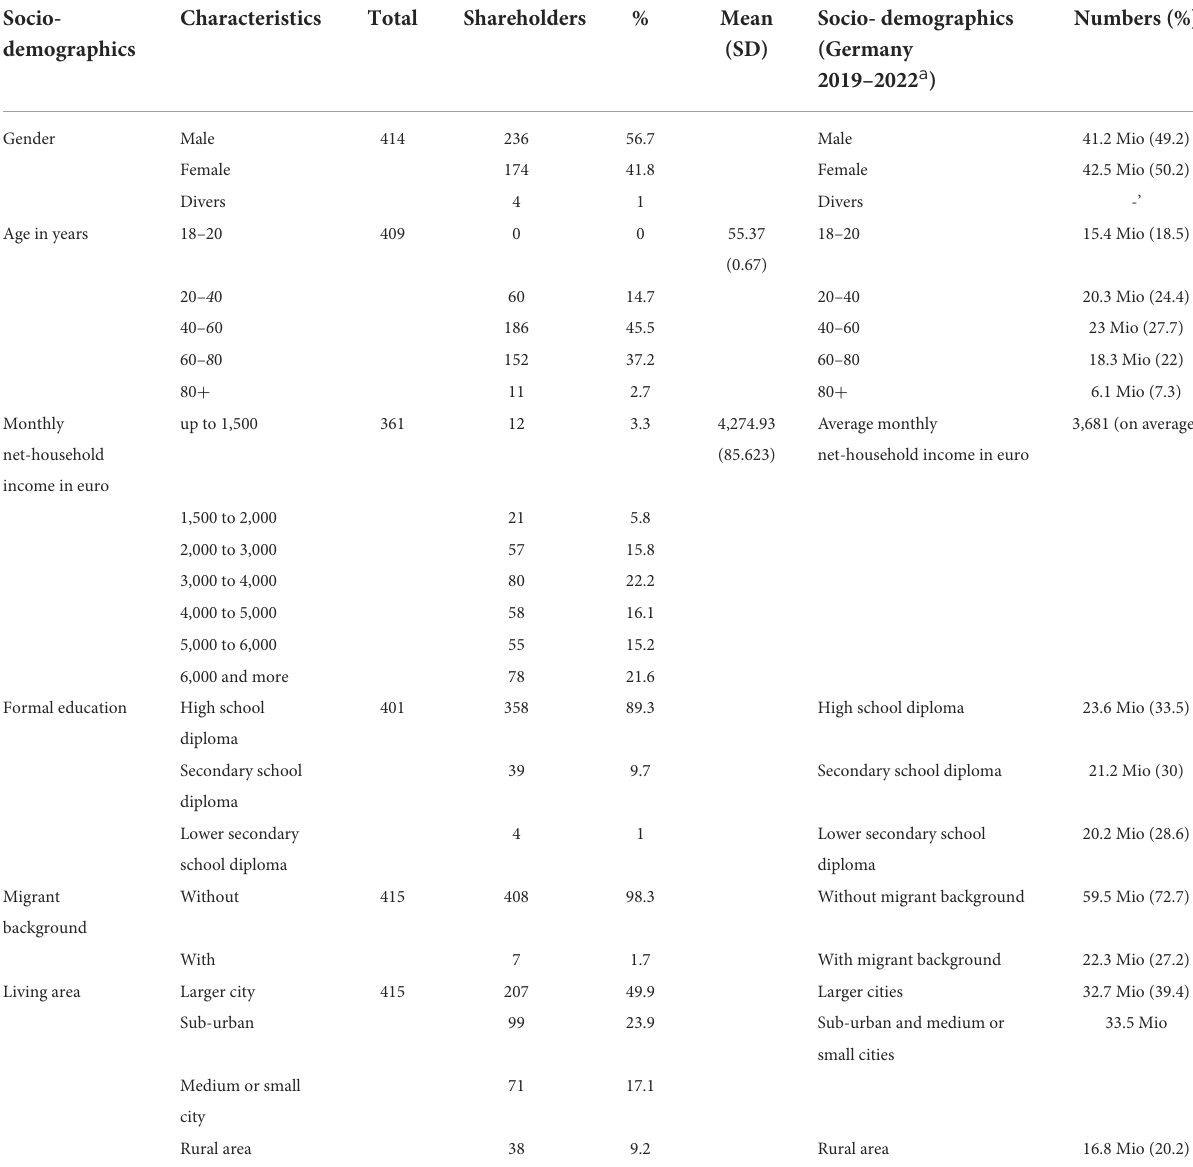
TABLE 3 Socio-demographic data of shareholders and for